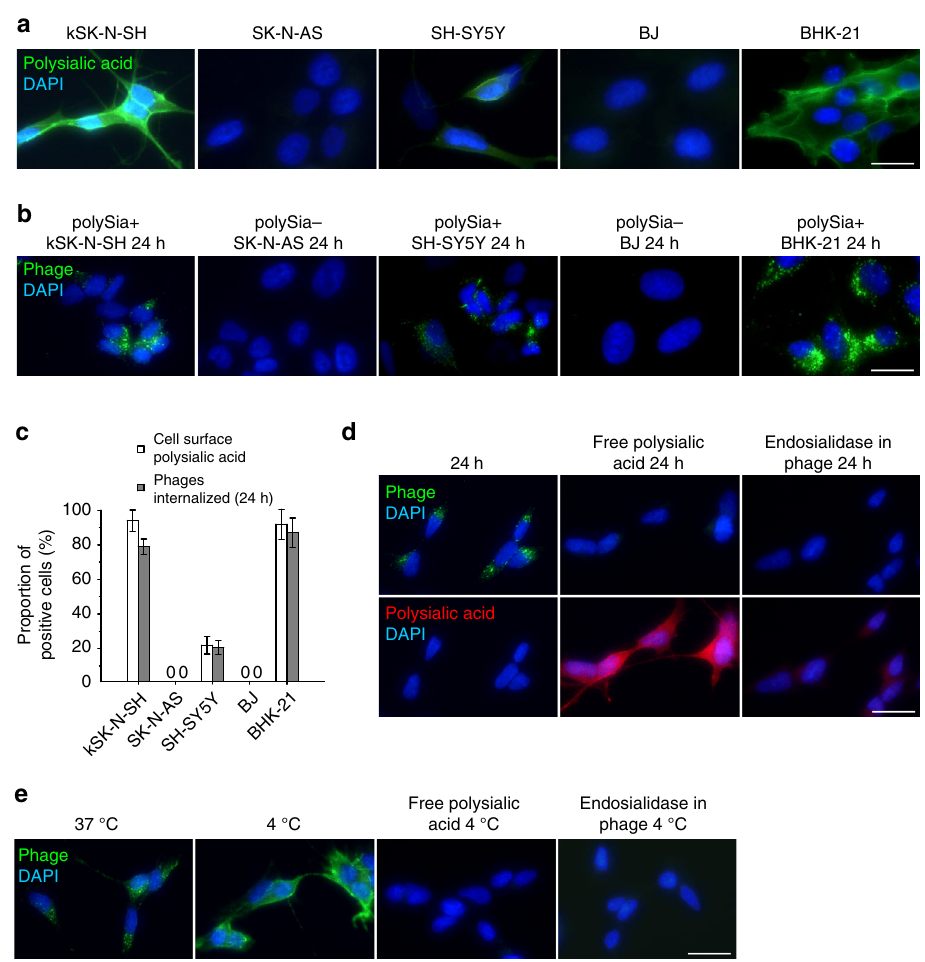
Fig. 3 Phage internalization requires polysialic acid. a Detection of cell surface polysialic acid in human neuroblastoma (kSK-N-SH, SK-N-AS and SH-SY5Y), human fi broblast (BJ) and hamster kidney (BHK-21) cells. The cells were grown on coverslips, fi xed and stained for surface-expressed polysialic acid. b Internalization of FITC-labeled PK1A2 phages into polysialic acid-containing (polySia+ ) cells compared to polysialic acid-negative (polySia − ) cells after 24 h of incubation at 37 °C. c Quantitative analysis of phage internalization. Percentages of cells expressing cell surface polysialic acid or having endocytosed FITC-labeled phages after incubation with phages for 24 h at 37 °C. The values represent means of three randomly chosen fi elds ± s.d. of a single experiment. For each fi eld, at least 25 cells were examined. d Inhibition of phage internalization. kSK-N-SH cells incubated with phages (green) in the absence or the presence of free polysialic acid, or control phages containing active endosialidase for 24 h at 37 °C. After incubation, the cells were fi xed and stained for surface-expressed polysialic acid (red). e Effect of low temperature on phage internalization. kSK-N-SH cells were incubated with phages in the absence or the presence of free polysialic acid for 4 h at 37 or 4 °C, or control phages containing active endosialidase for 4 h at 4 °C. Nuclei were stained with DAPI (blue). All data shown are representative for two biological replicates. The scale bars represent 20 µ